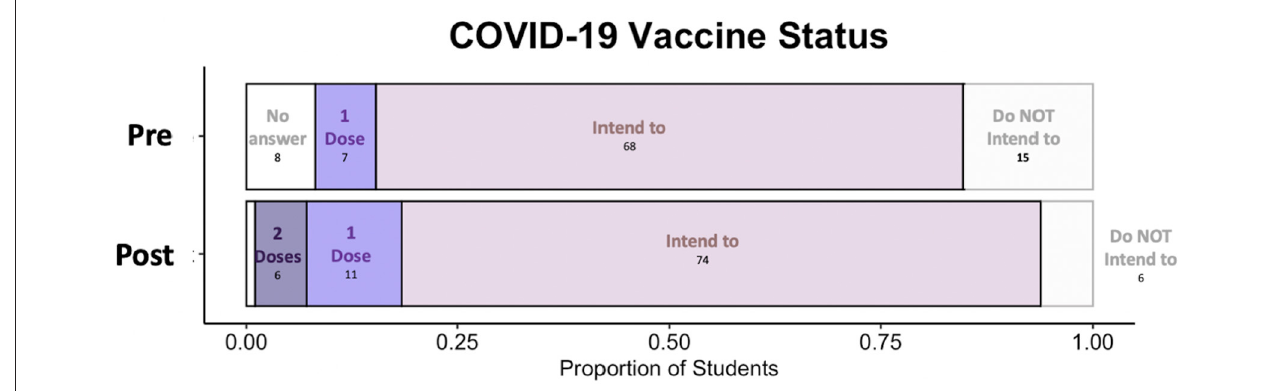
FIGURE 2 | Pre and post COVID-19 vaccination status. Pre indicates prior to the module and post indicates perception following module completion. Student agreement ranges from having two doses of the vaccine (left most and darker purple) to not having any intention of vaccination (right most and lighter). Some students opted to report “Prefer not to answer.” The proportion of total students is on the X axis, where N =